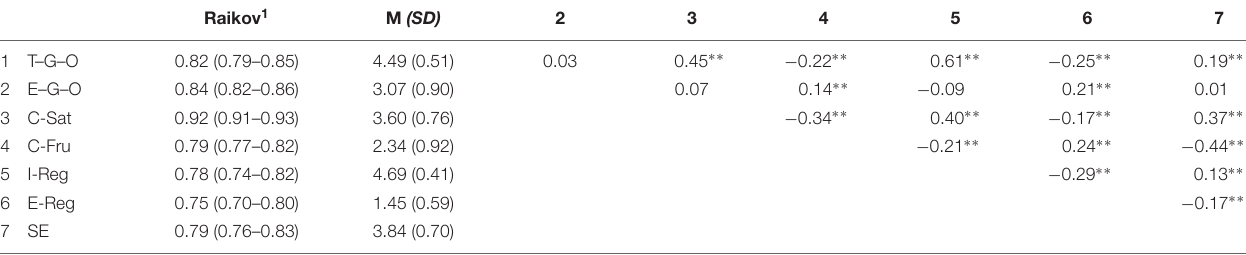
TABLE 1 | Descriptive statistics, Rho, and bivariate correlations for latent variables.